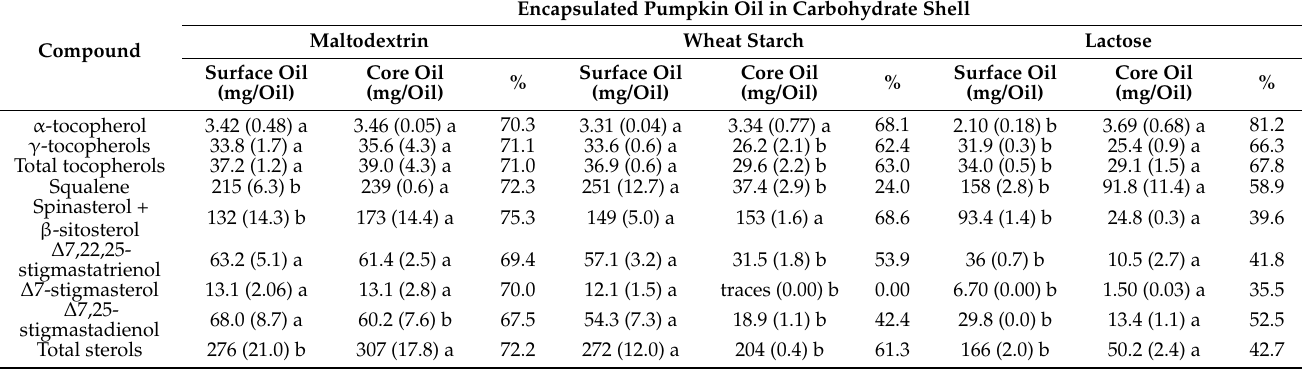
Table 5. Comparison of bioactive unsaponifiable compounds contents in surface and total oil of capsules with the greatest encapsulation